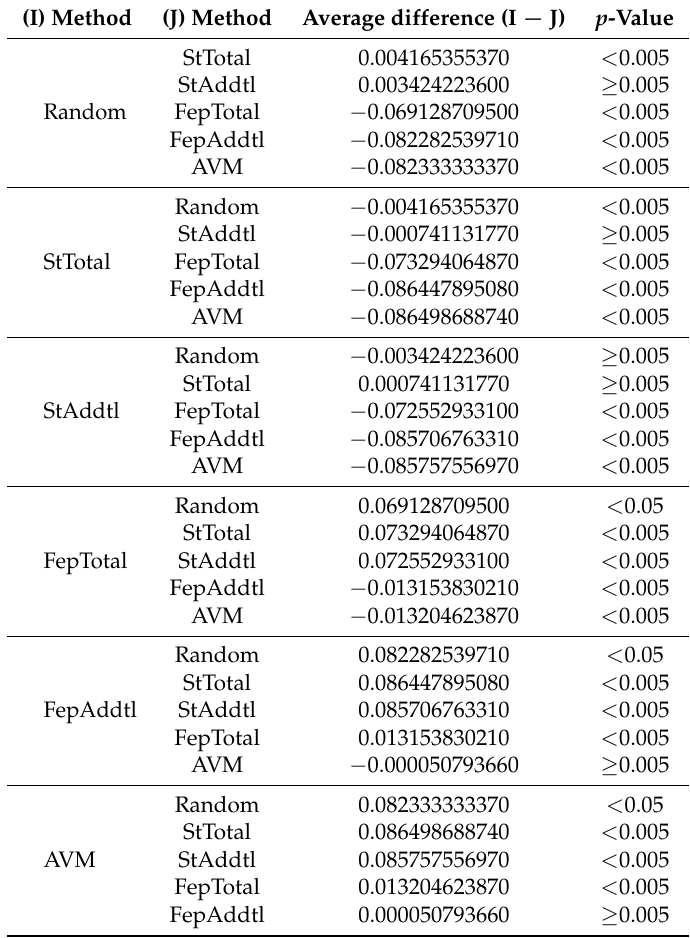
Table 5. Scheffe post-hoc test results for the PWS Puddle